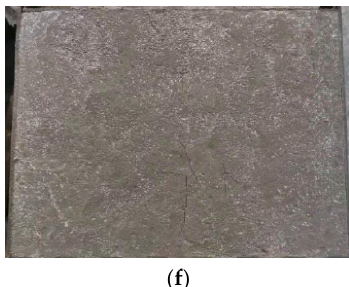
Figure 6. Early-age cracking performance: ( a ) POM-0; ( b ) POM-0.2; ( c ) POM-0.4; ( d ) POM-0.6; ( e ) POM-0.8; ( f ) POM-1.